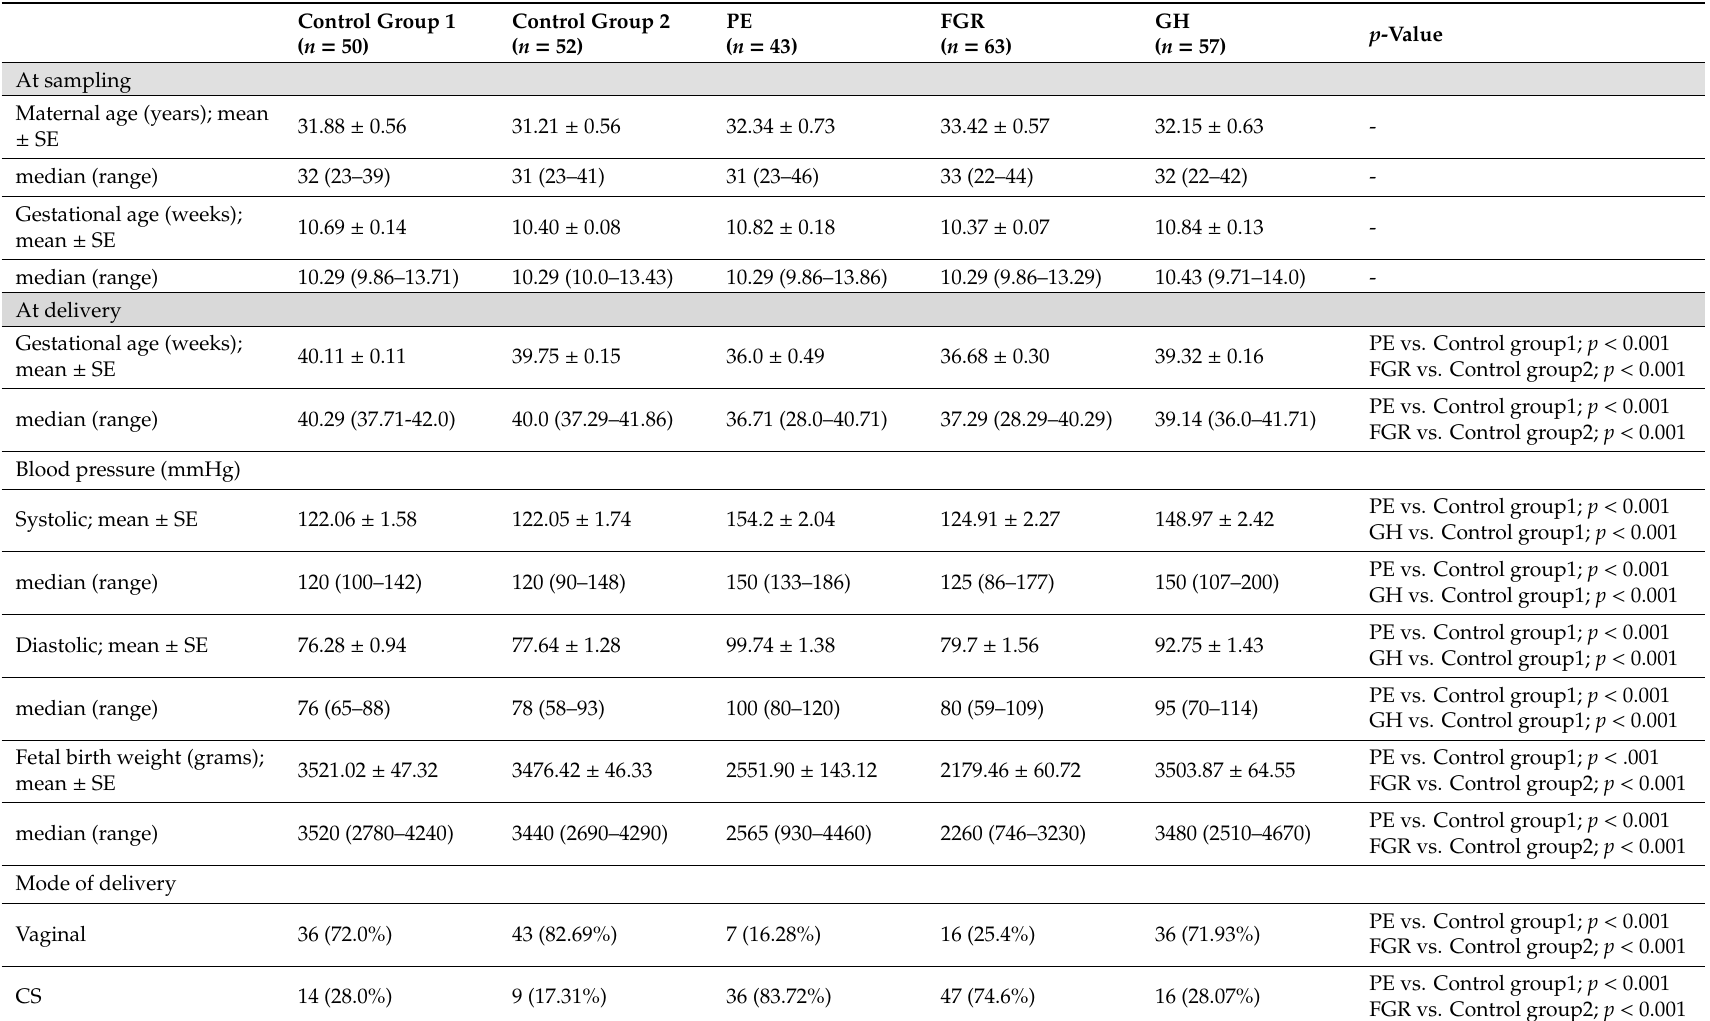
Table 1. Clinical characteristics of the controls and complicated